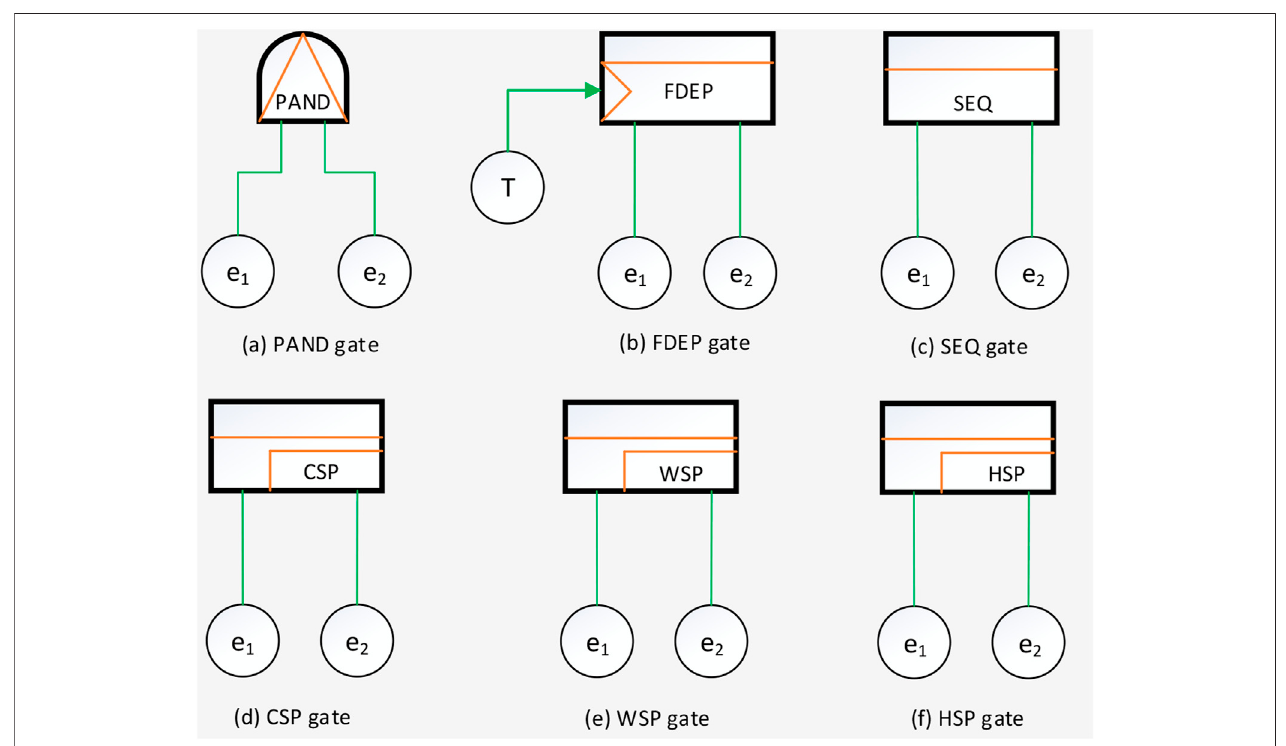
FIGURE 3 | Dynamic gates: (A) PAND gate; (B) FDEP gate; (C) SEQ gate; (D) CSP gate; (E) WSP gate; (F) HSP